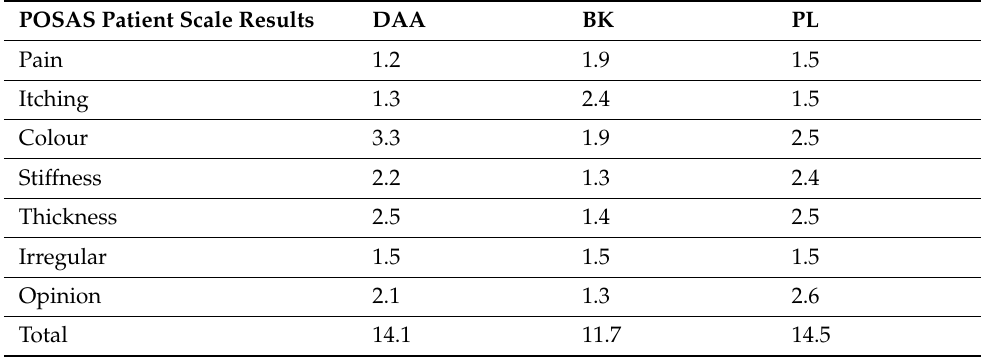
Table 3. POSAS patient scale results divided by